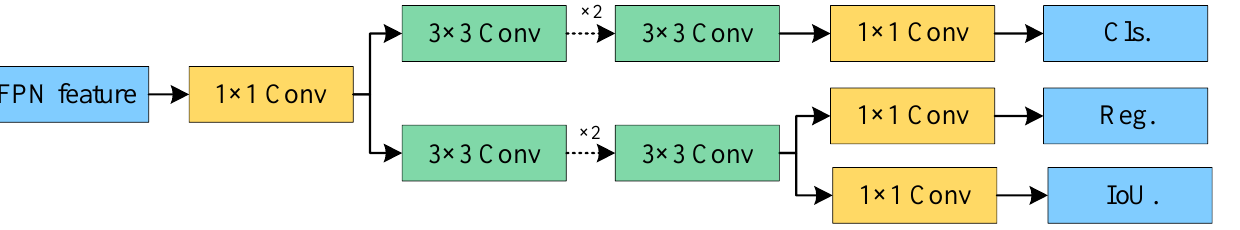
Figure 9. The architecture of Decoupled